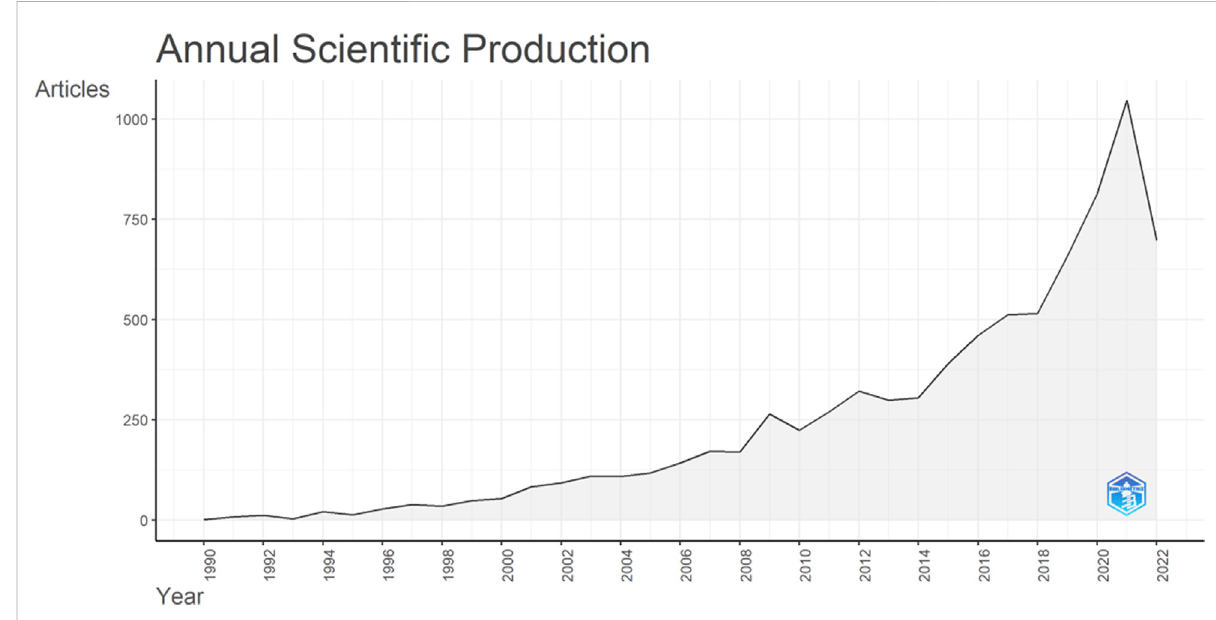
FIGURE 1 Annual scienti fi c production over time. The x-axis indicates years, while the y-axis indicates several articles published.